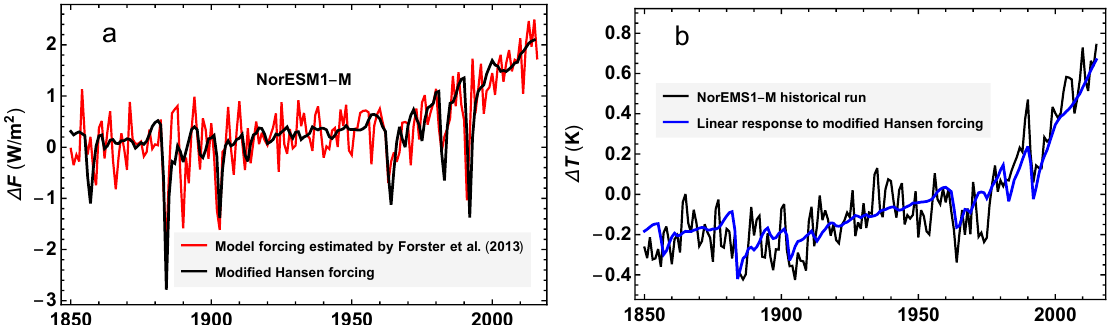
Figure 1. ( a ) The red curve is the adjusted forcing for the NorESM1-M model provided by Forster et al. [15]. The black curve is the forcing data of Hansen et al. [16] modified so that its 17-year moving average equals the 17-year moving average of the red curve. ( b ) The black curve is the global surface temperature in the historical run of the NorESM1-M model, and the blue curve is the response to the modified Hansen forcing (the black curve in ( a )) for the model given by Equation (5). Parameters are estimated as β = 0.67 and µ = 7.8 × 10 − 3 y − 1